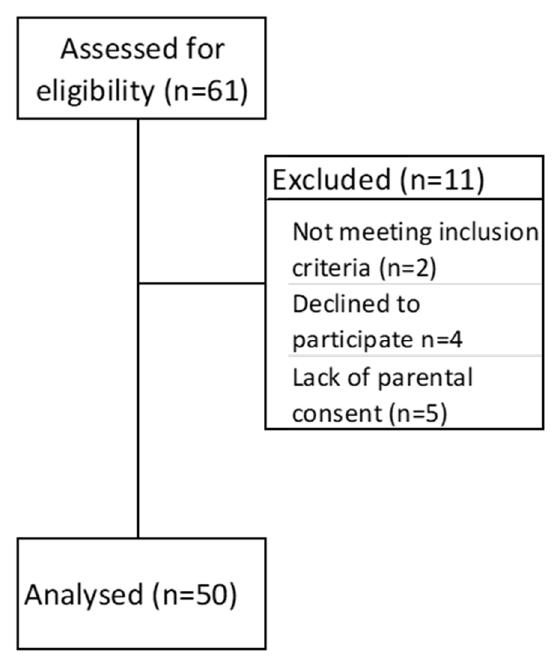
Scheme 1. Flow chart of participation.